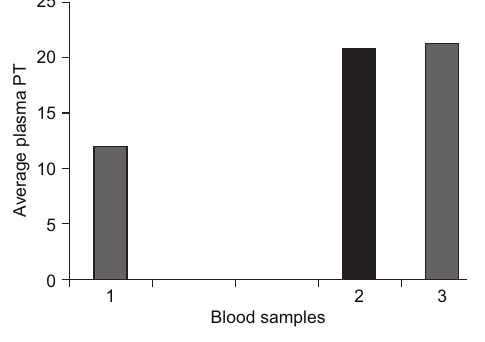
Figure 4 Bar diagram of plasma prothrombin time (s). Blood sam- ples: 1, normal blood plasma; 2, blood plasma sample of coumarin; 3, blood plasma sample of Zn-coumarin.